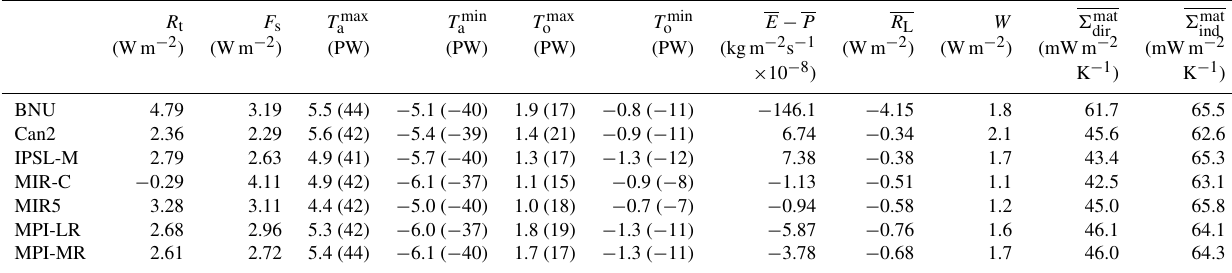
Table 4. Same as in Table 2 for the period 2071-2100 of the RCP8.5 runs.